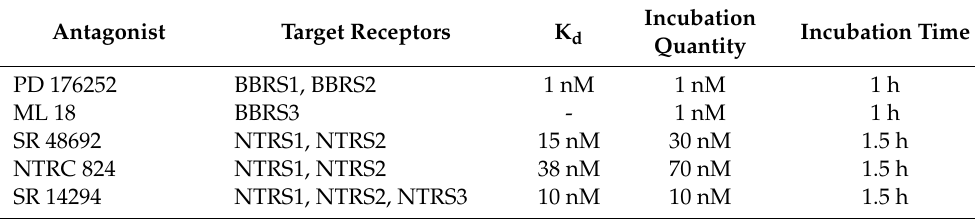
Table 3. The amounts of antagonists used to evaluate specific